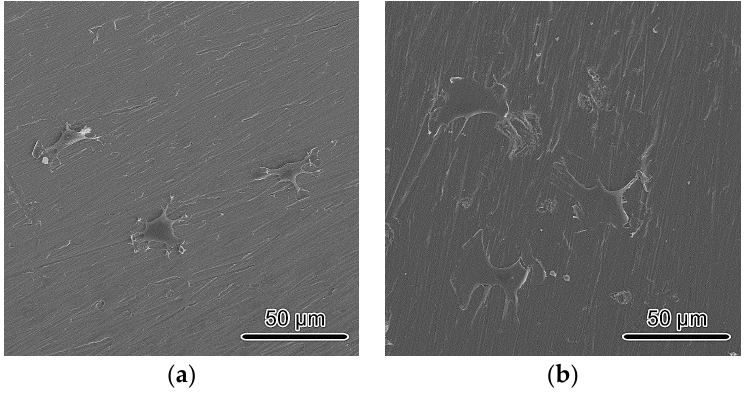
Figure 6. Morphologies of cells on ( a ) AC; ( b ) HS specimens 3 h after seeding.